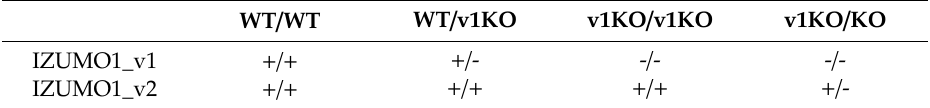
Table 1. Four di ff erent mouse lines of Izumo1 gene disruption. Note that the WT, v1KO and KO mouse lines have wild-type, IZUMO1_v1 knockout, and both IZUMO1_v1 and v2 knockout alleles, respectively. Corresponding to their genetic background, each allele is expressed as a plus or